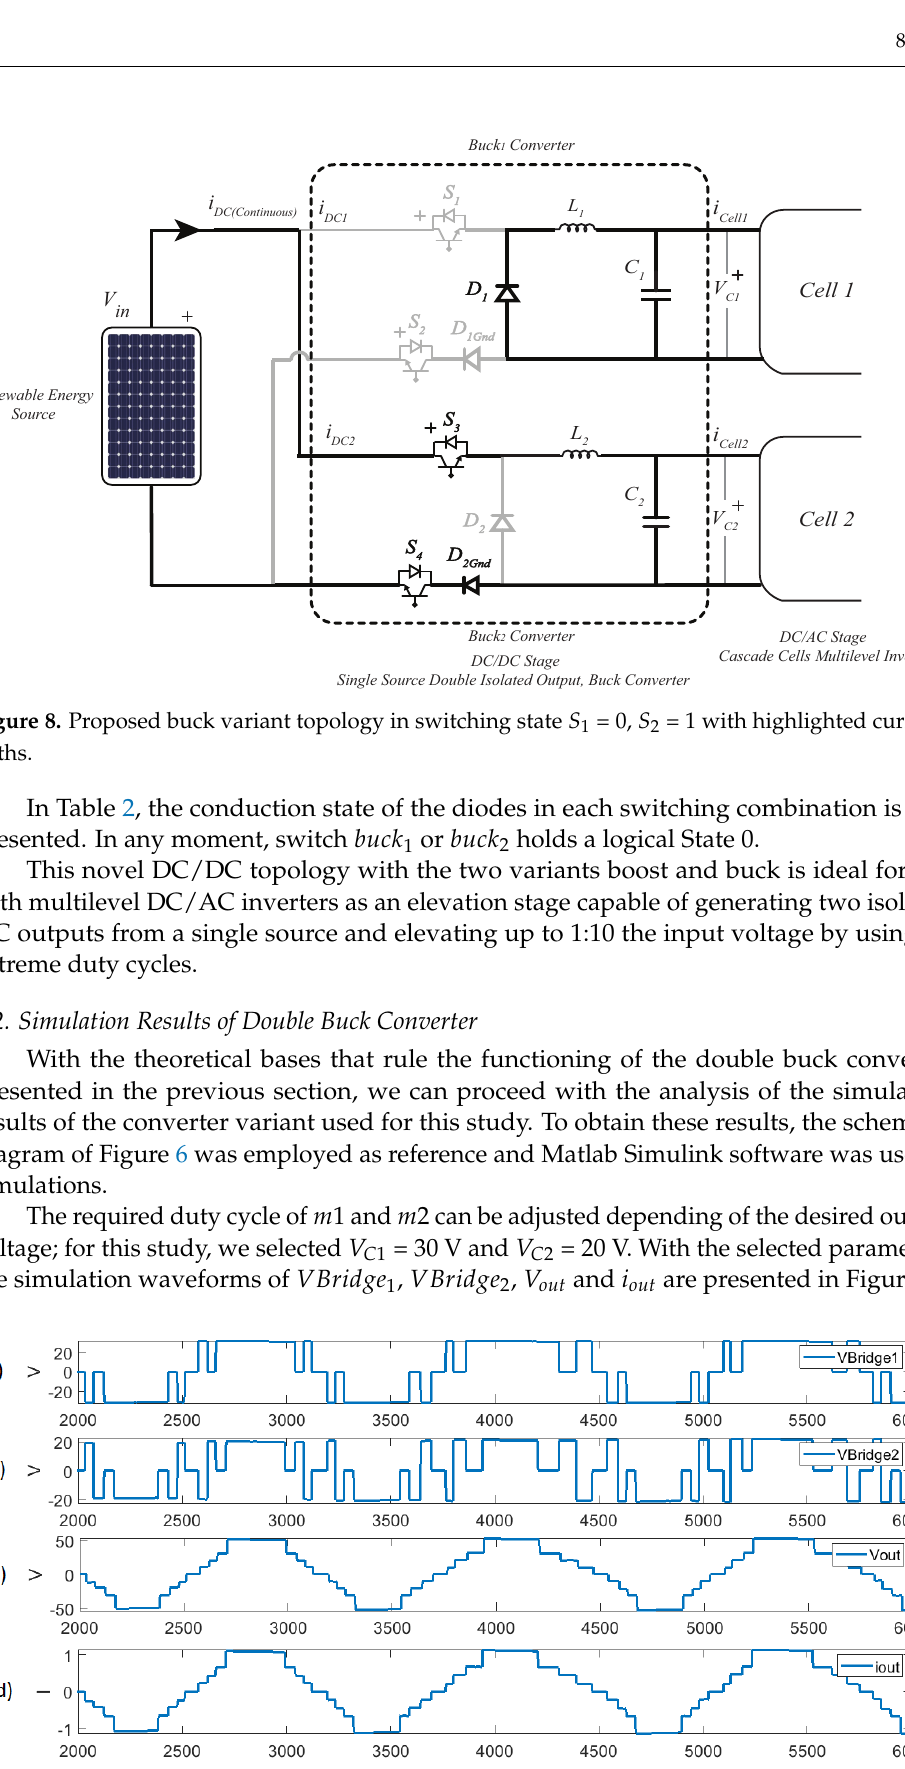
Figure 9. Simulation results of the proposed DC/AC topology: ( a ) VBridge 1 ; ( b ) VBridge 2 ; ( c ) V out ; and ( d ) I out